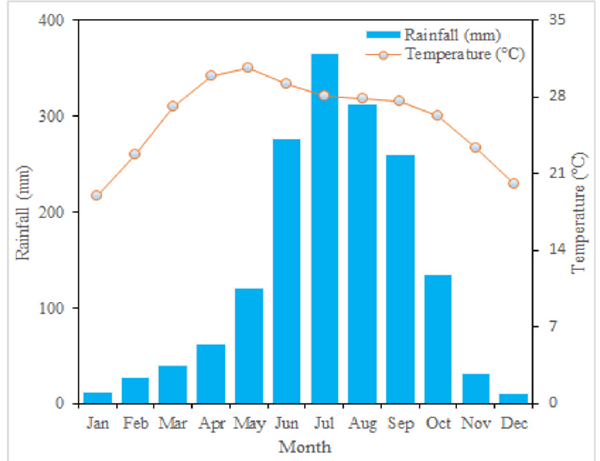
Figure 2. Monthly rainfall and temperature in KMC during 1997–2019.